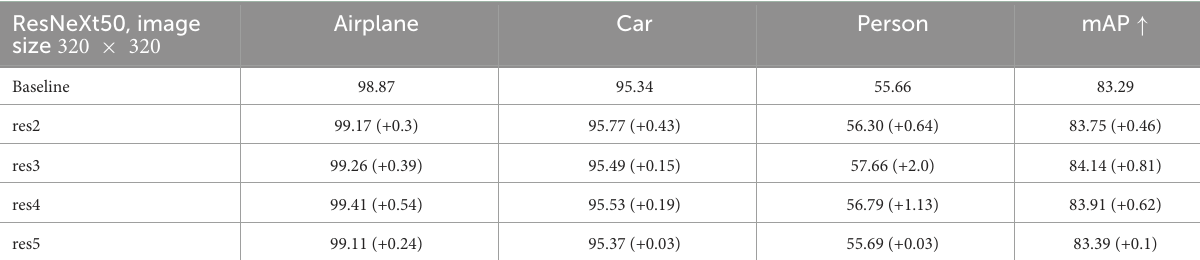
TABLE 2 Detection results on airport dataset by replacing the penultimate residual block of the different stages of ResneXt50 backbone with the proposed M-DRF ( M = 8). ResNeXt50, image size 320